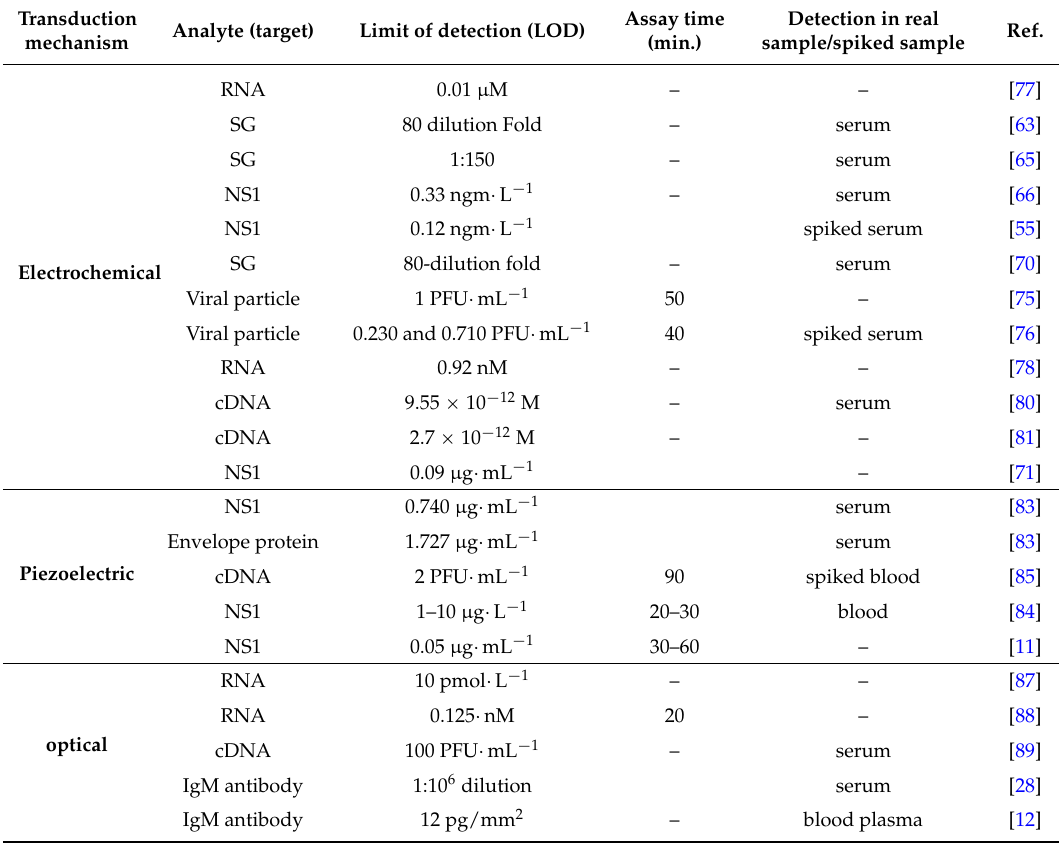
Table 4. Reported LODs and assay times for